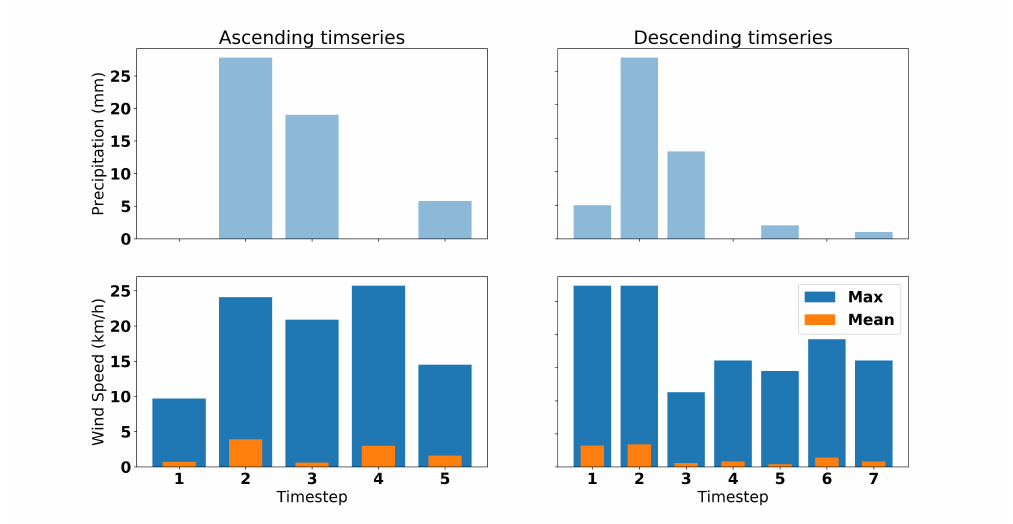
Figure 21. Additional weather data for ascending and descending time series (SITS): precipitation, maximum wind speed, mean wind